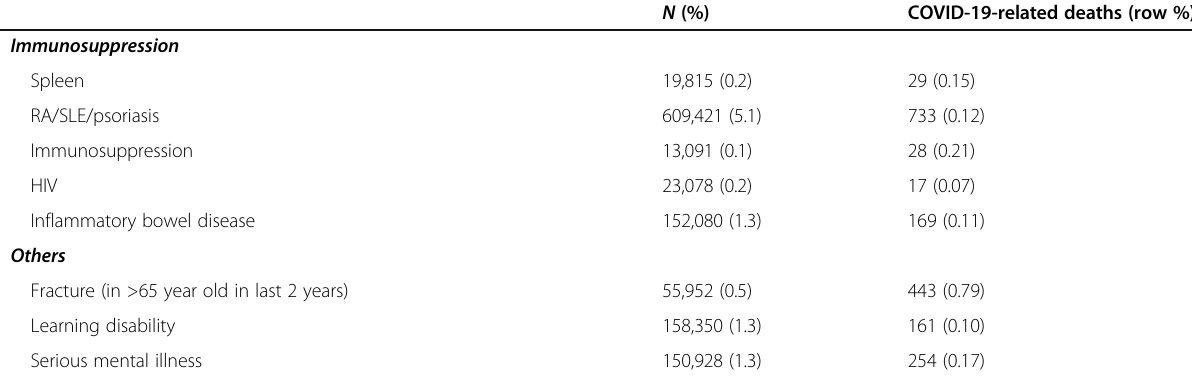
Table 1 Description of base cohort (Continued)